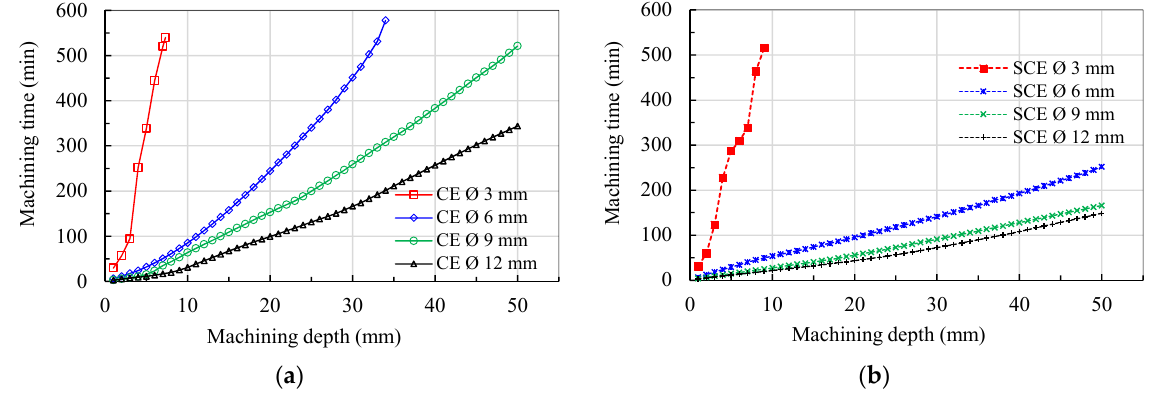
Figure 3. Machining time versus machining depth of drilled holes. ( a ) Results of conventional electrode (CE); ( b ) results of step cylindrical electrode (SCE).